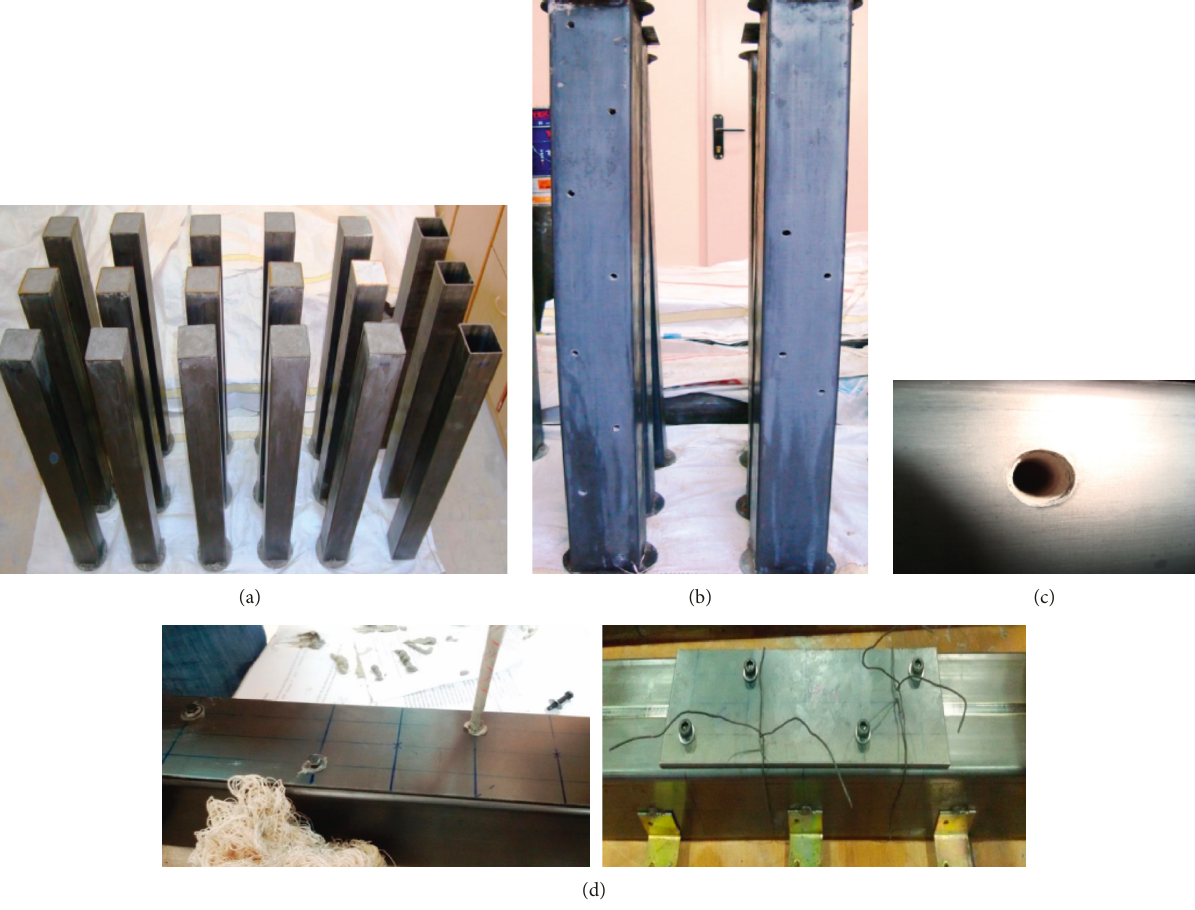
Figure 5: Preparation stages for the retrofitted beams. (a) SCCFST beams. (b) Drilled SCCFST beams. (c) Typically drilled hole. (d) Application of epoxy and installation of bolts through holes. Table 6: Dimensions and details of the beam